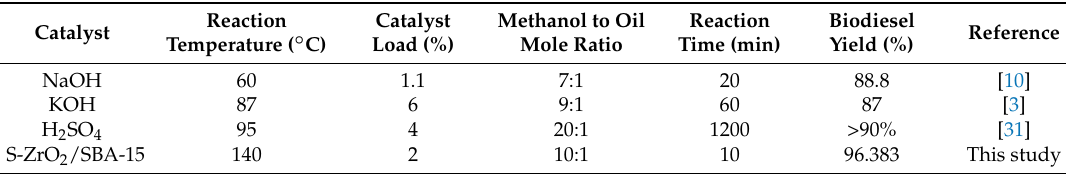
Table 7. Comparison of the catalytic performance between a heterogeneous S-ZrO 2 /SBA-15 acid catalyst and homogeneous catalysts.